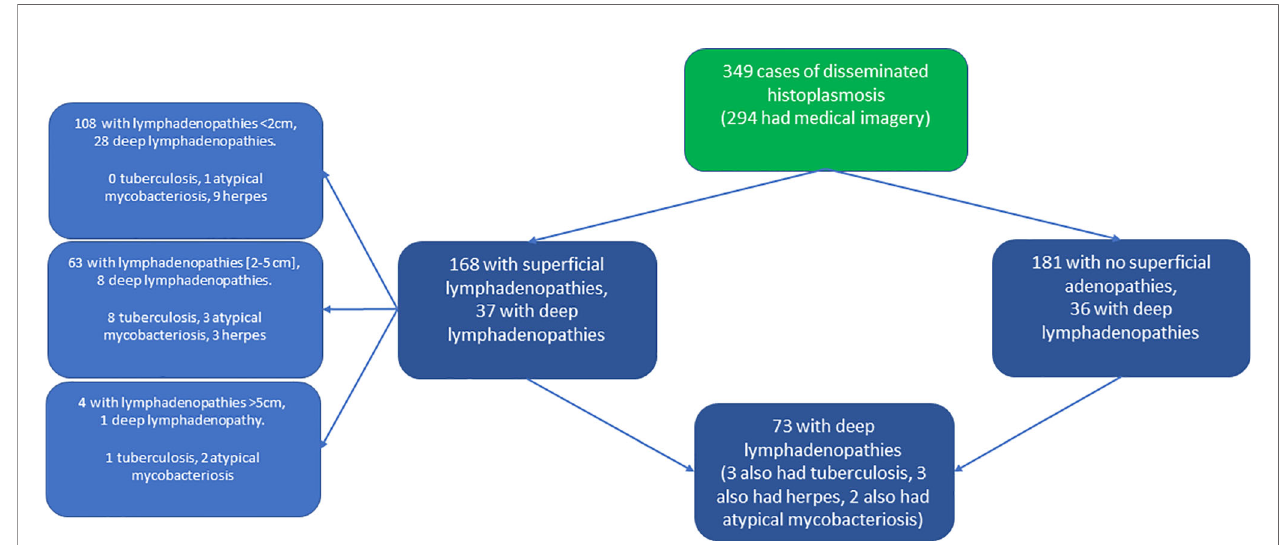
FIGURE 1 | Flowchart stratifying patient counts by presence of super fi cial or deep